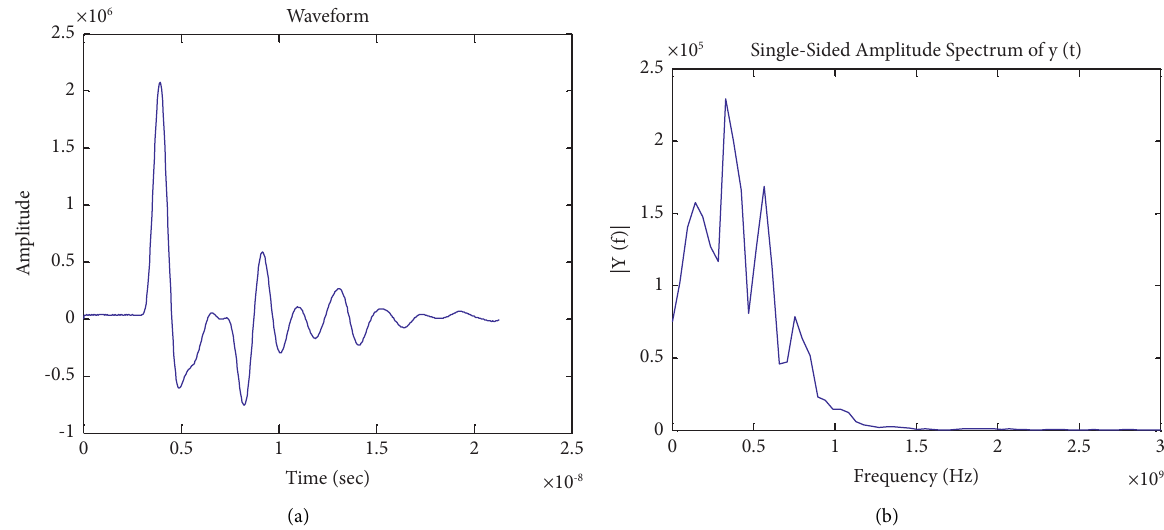
Figure 2: (a) GPR signal of dry ballast. (b) FFT spectrum of GPR signal of dry